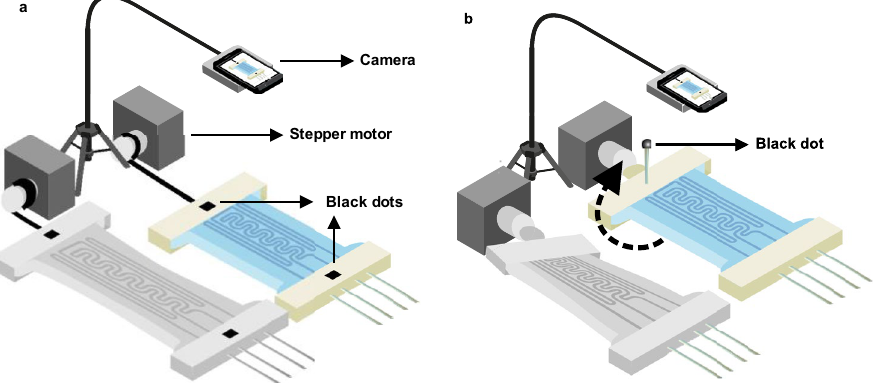
Figure 8. The designed setup for logging distance and angle data from ( a ) stretching and ( b ) twisting the